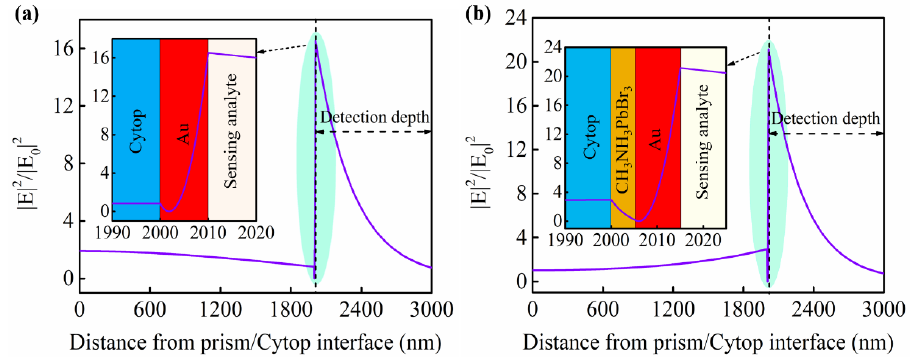
Figure 2. The electric field distribution of the plasmon sensors based on ( a ) LRSPR and ( b ) GW − LRSPR at the resonance angle ( θ res = 34.6100° for LRSPR, θ res = 34.6652° for GW − LRSPR). There are four approaches for calculating the sensitivity of a sensor [23], including intensity sensitivity, angular sensitivity, spectral sensitivity, and phase sensitivity. For an ‐ gular sensitivity, a previous report demonstrated that the selection of coupling prism has a great impact on the performance of the sensor [19]. Therefore, it is necessary to analyze the influence of the coupling prism on the sensitivity of the proposed GW − LRSPR sensor. Herein, the intensity sensitivity was used to calculate and analyze the performance of the proposed sensor, which is different from the angular sensitivity. Figure 3a,b shows the reflectance and intensity sensitivity for the proposed GW − LRSPR sensor based on SF10 and BK7, respectively. The intensity sensitivity for the SF10 ‐ based GW − LRSPR sensor was 1131.2 RIU − 1 (Figure 3a), while the intensity sensitivity for the BK7 − based GW − LRSPR sensor was 1030.1 RIU − 1 (Figure 3b). These results were similar to the intensity sensitivity of the 2S2G − based sensor shown in Figure 1d,f. Assuming that the RI of the prism was variable, the intensity sensitivities of the proposed GW − LRSPR sensor under different prisms were calculated and are shown in Figure 3c. The results demonstrated that the coupling prism with different RIs had little effect on the intensity sensitivity of the pro ‐ posed GW − LRSPR sensor. Therefore, 2S2G, SF10, and BK7 can all be used as coupling prisms in the proposed GW − LRSPR sensor, and will not have a significant impact on in ‐ tensity sensitivity. According to Snell’s law, a change in the RI of the prism will lead to a change in the critical angle of total reflection. With the increase in the RI of the prism, the critical angle of total reflection will gradually decrease; therefore, the resonance signal will also move toward the direction of a small angle. In this process, the characteristics of the resonance signal were basically unchanged and the sensitivity changed slightly.